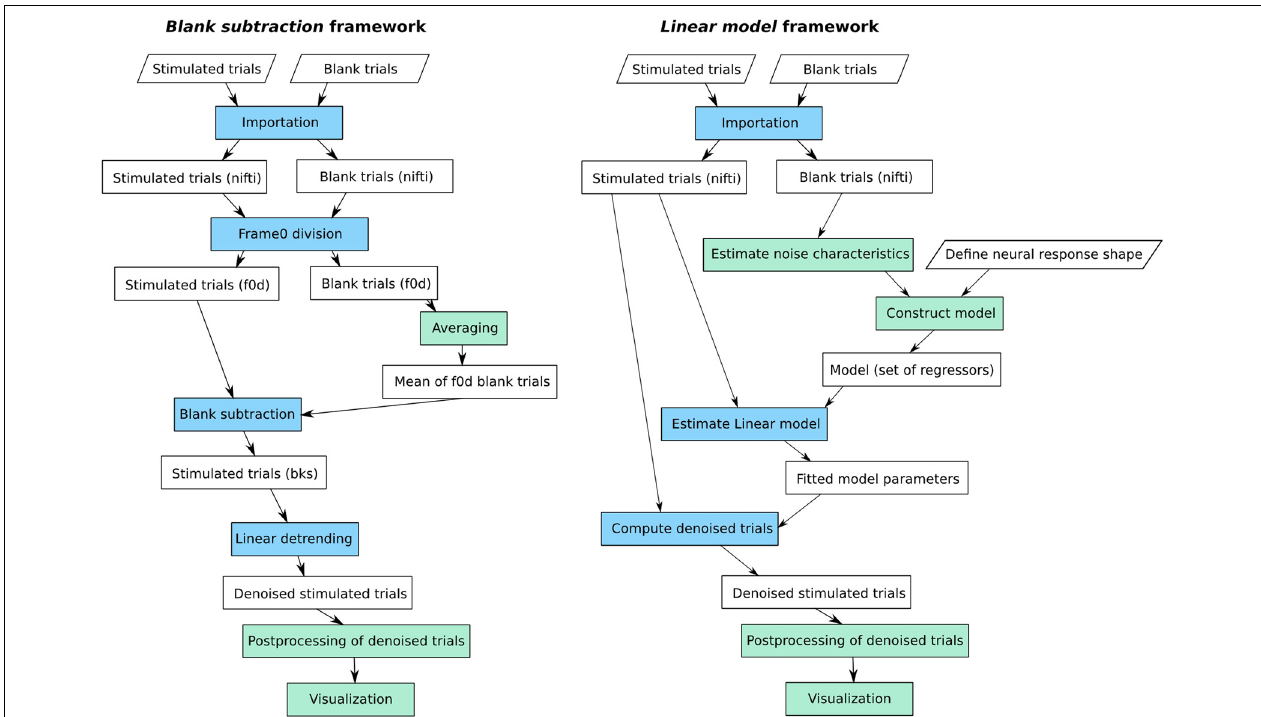
FIGURE 3 | The two main workflows available in Vobi One : the standard blank subtraction method (on the left), and the linear model from (Reynaud et al., 2011) (on the right). In green: session-level processes; in blue: trial-level processes, repeated on each individual